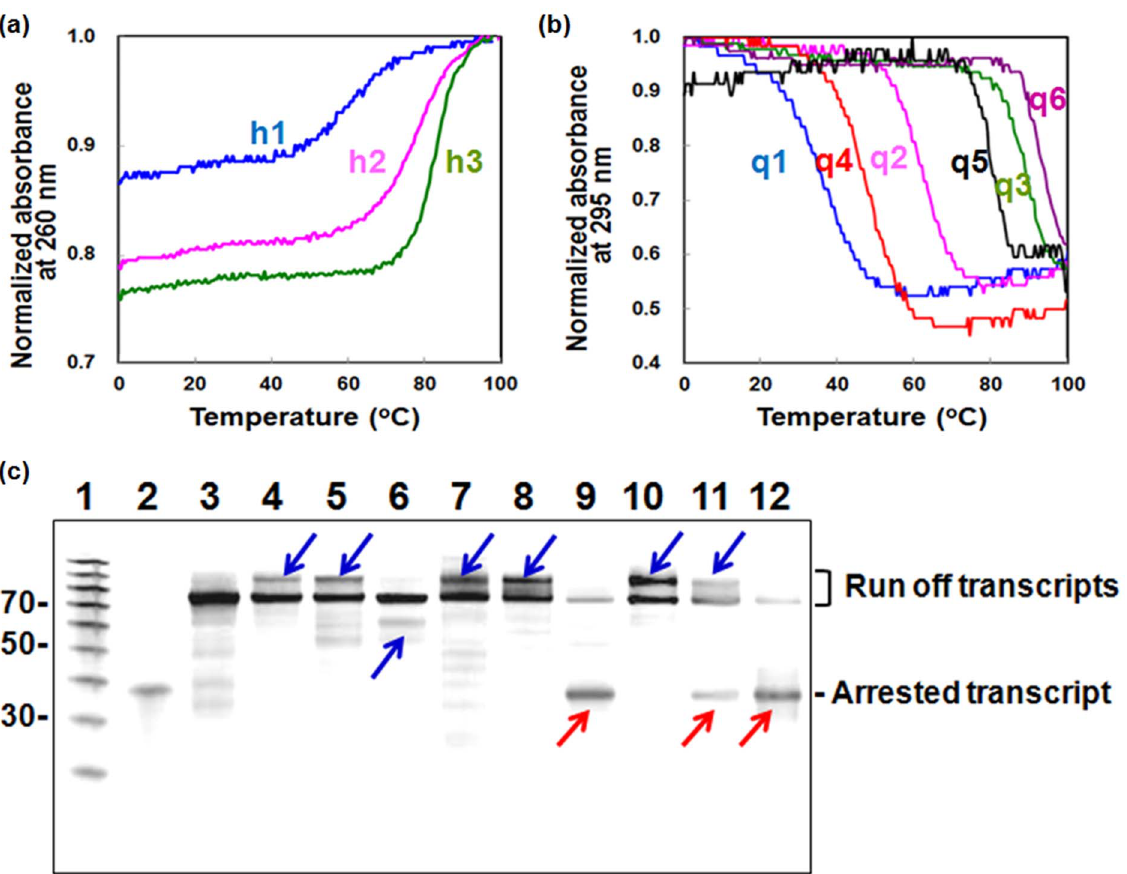
Figure 2. UV melting curves for oligonucleotides containing sequences in DNA templates (a, b) and effects of non-canonical structures in the template DNA on transcription (c). Normalized UV melting curves for 2 m M (a) h1 (blue), h2 (pink), and h3 (green), (b) q1 (blue), q2 (pink), q3 (green), q4 (red), q5 (black), and q6 (purple) in a buffer containing 30 mM KCl, 40 mM Tris-HCl (pH 8.0), 8 mM MgCl 2 , and 2 mM spermidine. The T m values for h1, h2, h3, q1, q2, q3, q4, q5, and q6 were 55.5, 74.5, 82.4, 37.3, 62.9, 89.8, 46.8, 80.5 and . 95 u C. (c) Denaturing gel electrophoresis of products of transcription reactions carried out for 90 min at 37 u C. Reaction mixtures contained 0.3 m M T7 polymerase and 1.5 m M DNA template in a buffer containing 30 mM KCl, 40 mM Tris-HCl (pH 8.0), 8 mM MgCl 2 , and 2 mM spermidine. Lane 1, size marker; lane 2, 35-nt RNA; lanes 3 to 12, transcription products for Linear, H1, H2, H3, Q1, Q2, Q3, Q4, Q5, and Q6 templates, respectively. Blue and red arrows indicate the slipped and arrested transcripts, respectively.